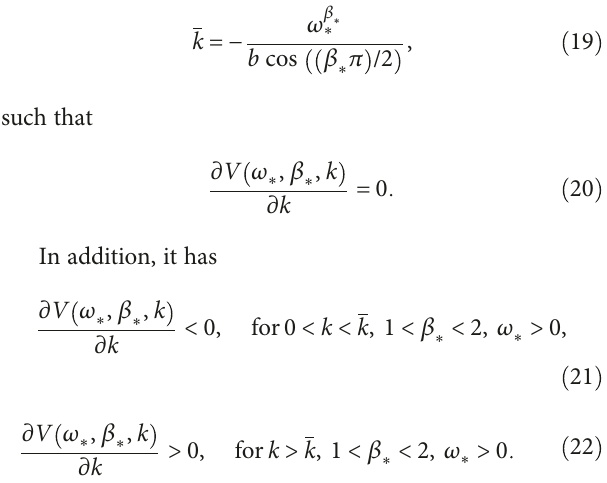
β ∗ , ∗ , k and k under